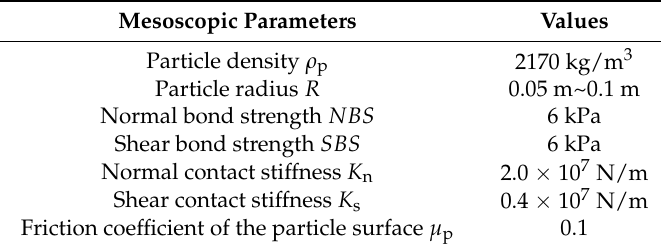
Table 3. The mesoscopic parameters of the example.